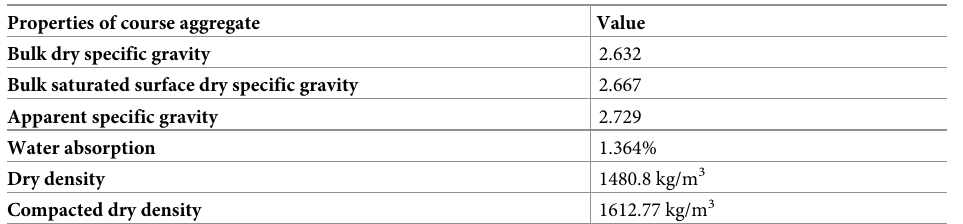
Table 1. Properties of course